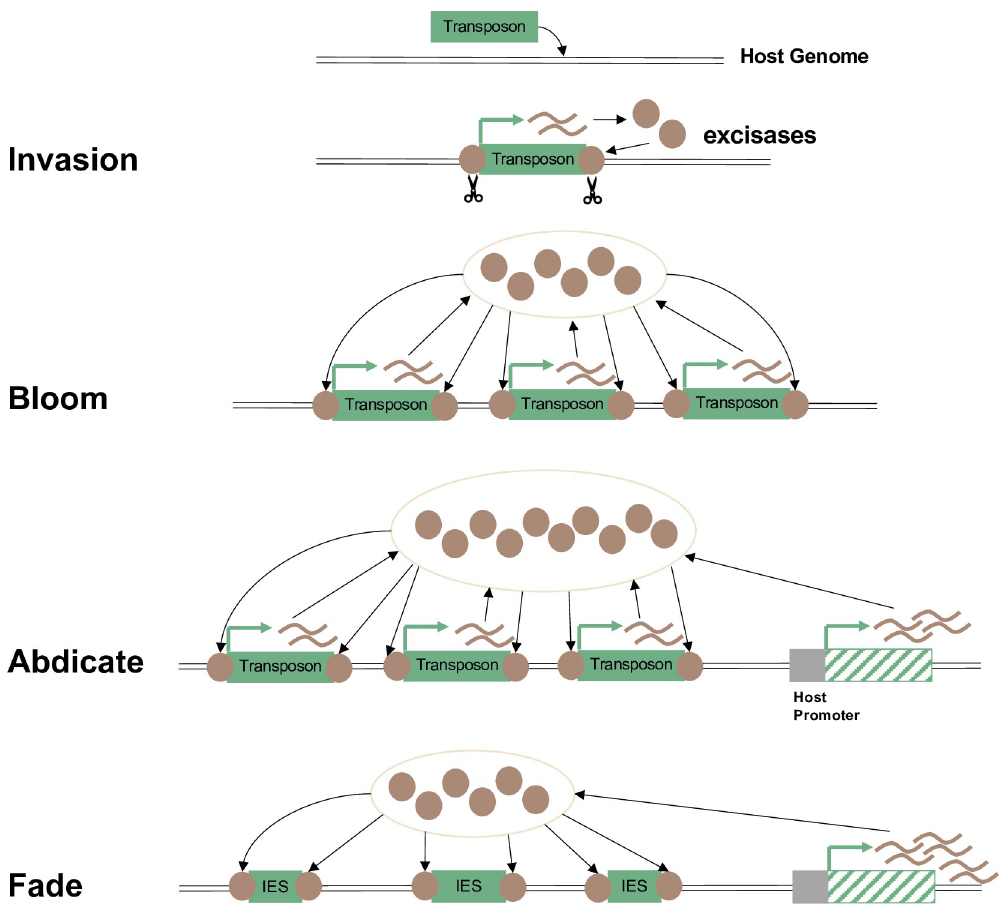
Fig 1. Klobutcher and Herrick’s original proposal [4] that most IESs are the decayed remnants of transposons. This model is abbreviated as “IBAF” to describe the gradual conversion of transposons into IESs in 4 steps: invasion, bloom, abdicate, and fade. Invasion: One or more transposons, perhaps of the IS630-Tc1-mariner superfamily (green box), invaded the host ciliate germline genome, and many transposons may still be active to this day. Active transposons encode a transposase (brown circles) that permits their excision from or movement within the genome. Bloom: Transposon expansion via replicative transposition across the genome. Their encoded transposase/excisase proteins, capable of acting on each other, become a common good, contributing to the excision of transposons other than one’s self. Abdicate: A gene (green hashed box) that encodes the excisase becomes placed under a host promoter for stable and regulated expression, but loss of mobility. In some cases, this gene may also be retained in the MAC (e.g., PiggyMac in Paramecium tetraurelia ). Fade: Mutation accumulation in most transposons gradually converts them into short IESs, nonautonomous elements that retain motifs to permit their recognition and cleavage from the genome by host excisases. I AU : AnabbreviationlisthasbeencompiledforthoseusedthroughoutFig 1 : Pleaseverifythatallentriesarecorrect : BAF, invasion, bloom, abdicate, and fade; IES, internal eliminated sequence; MAC, macronucleus; MIC,